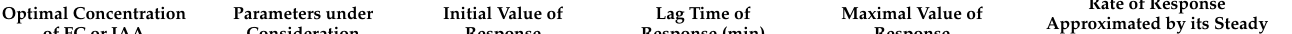
Table 1. Parameters of the FC (10 − 6 M)- and IAA (10 − 4 M)-induced rapid growth, medium pH and membrane potential of the maize coleoptile cells that had been incubated at the optimal concentrations of both effectors at 25 ◦ C. Rapid growth, medium pH and membrane potential in the maize coleoptile cells that had been treated with the optimal concentrations of FC and IAA for growth Optimal Concentration of FC or